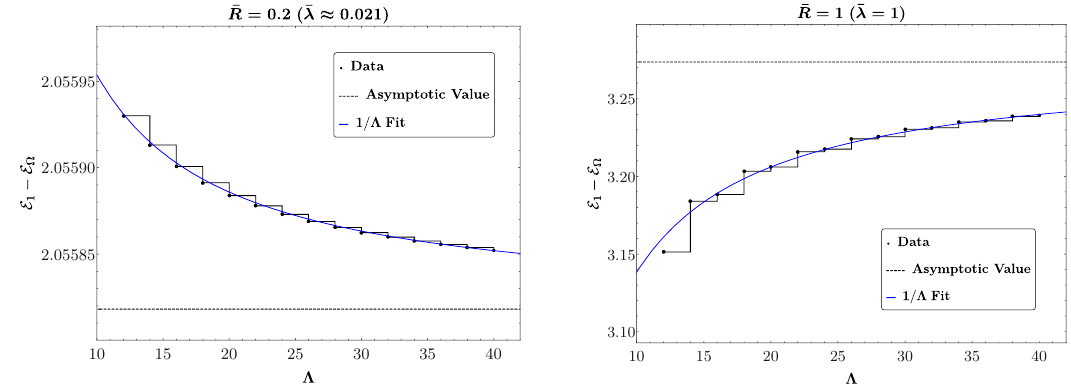
Figure 16. Energy of the first excited state in the Lee-Yang model, as a function of the cutoff at weak and strong coupling. Notice that the first excited state is parity even, hence again only points were Λ is even need to be computed. The asymptotic value is obtained from the fit.